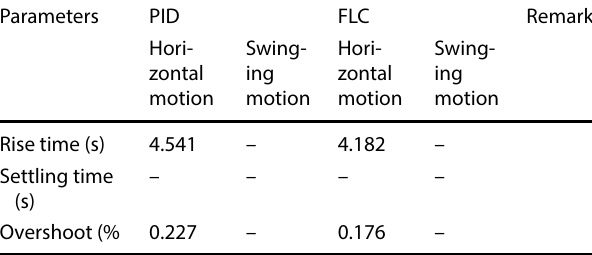
Table 3 The fuzzy logic and conventional PID controller results